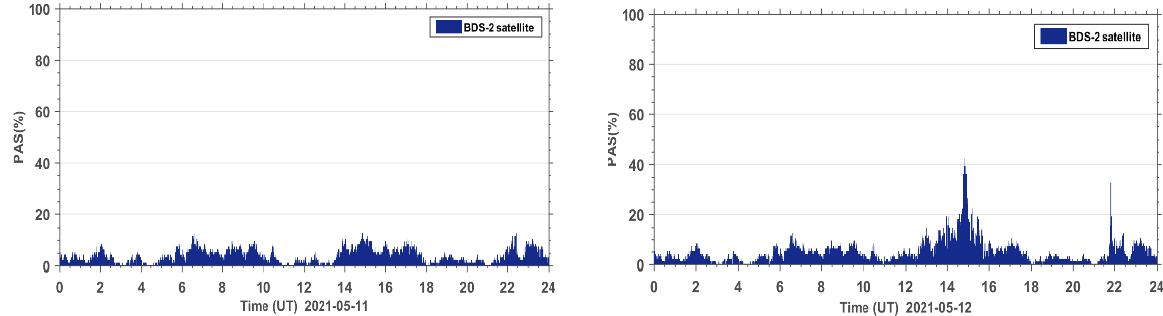
Figure 6. Time series of PAS for BDS2 sites worldwide during the reference day (11 May 2021) and the geomagnetic storm day (12 May 2021).